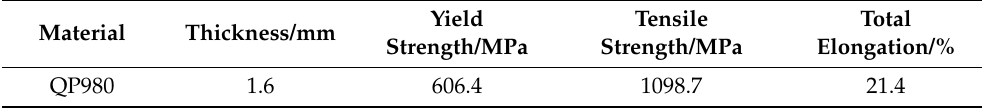
Table 1. Mechanical properties of QP980 steel.